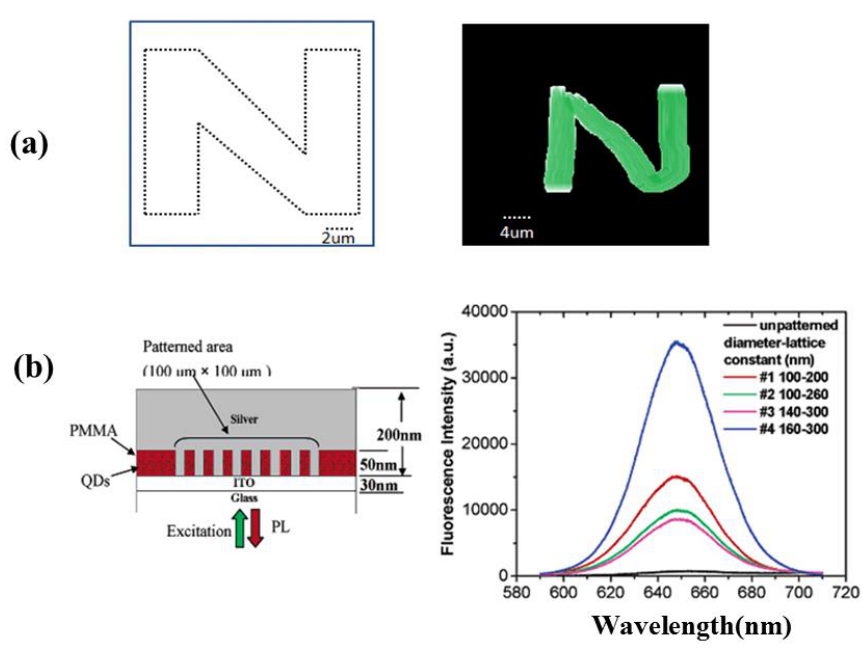
Figure 14. ( a ) Triangular Au particle array produced by electron beam etching and the fluorescence enhancement effect. Adapted from Ref. [89]. ( b ) Schematic of typical finished sample structure